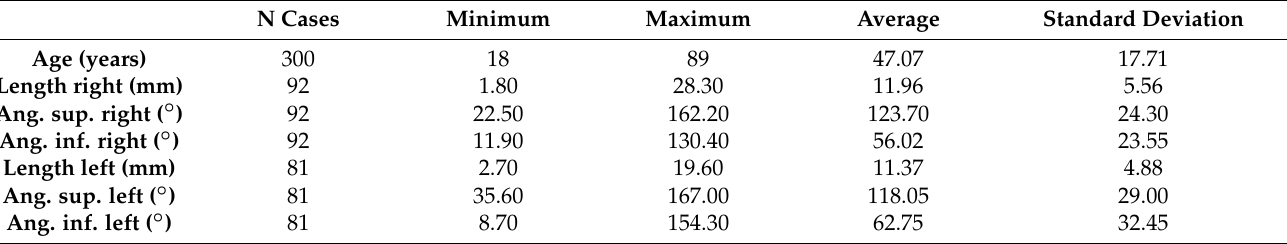
Table 3. Age and length of left and right sides.